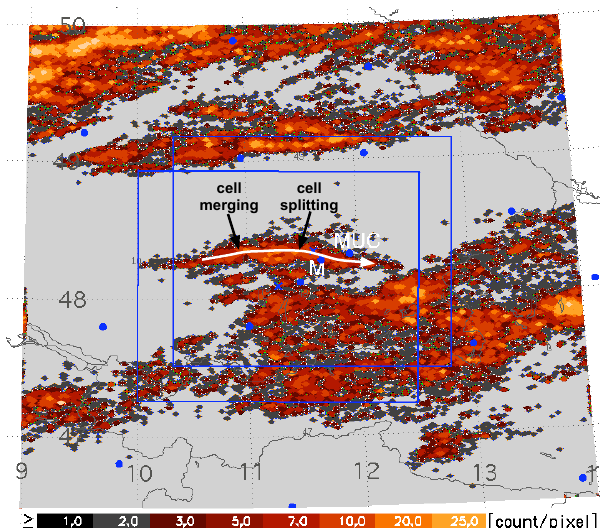
Fig. 8. Accumulated lightning intensity map for the example day 25 June 2008. The lightning frequencies per pixel of 3min accu- mulated lightning data for every 2.5min time step as described in Sect. 2.1.2 are shown in red shades. The coverage of the radar in F¨urholzen is marked by the upper right rectangle. Blue dots indicate LINET sensor locations. The cell track of the supercell discussed in the text is